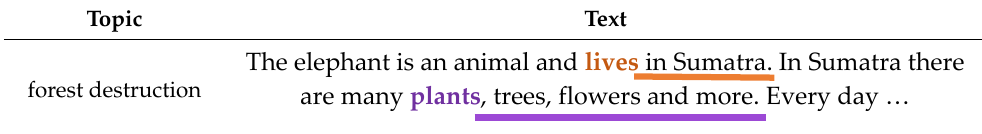
Table 3. Example material for the contextual cues intervention.